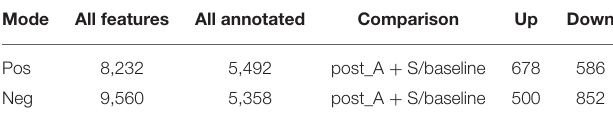
TABLE 1 | Statistical analysis of the fecal